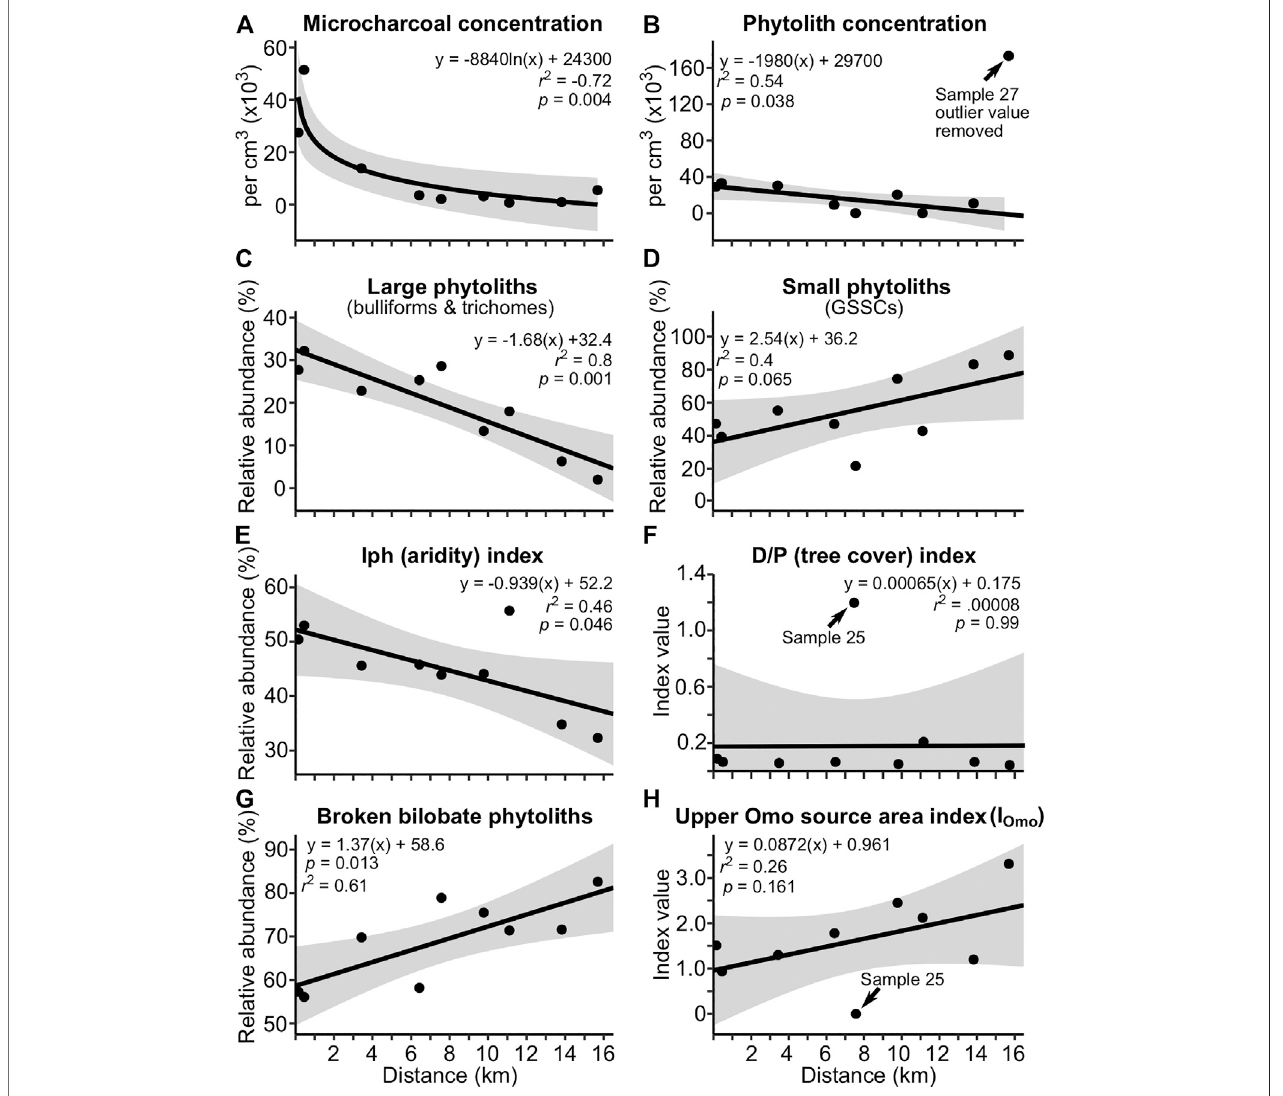
FIGURE 2 | Relationship between distance from shoreline and the relative abundance of selected phytolith and microcharcoal constituents of modern Lake Turkana sediment samples. Shaded regions represent regression 95% con fi dence intervals. Sample location numbers for points on the graphs are (left to right): 22, 21, 24, 33, 25, 32, 26, 31, and 27, respectively. As distance from shoreline increases, exposure to the Omo River sediment plume and proximity to the north basin gyre increases, but distance to the mouth of the Omo River does not appreciably change (see Figure 1D ). (A) Microcharcoal concentrations decrease exponentially as distancefromshorelineincreases. (B) Phytolithconcentrationsdecreaselinearlyasdistancefromshorelineincreases. (C) Large-sizedphytolithsdecreaseand (D) small- sized phytoliths increase as distance from shoreline increases. (E) The grass-based Iph (aridity) index decreases as distance from shoreline increases, presumably from the presence of phytoliths derived from the Omo River Valley. (F) The D/P ° tree cover index shows no relationship with distance from shoreline, presumably because phytolith-rich grasses are much more abundant than trees that produce phytoliths in both the Turkana Basin and Omo River Valley. (G) Broken bilobates increase as distance from shoreline increases, presumably because they are smaller, but also because some proportion may have been transported long-distance from the Omo River Valley. (H) Phytoliths derived from plants sourced to the Omo River Valley increase as distance from shoreline increases. See Table 3 for details on the I Omo